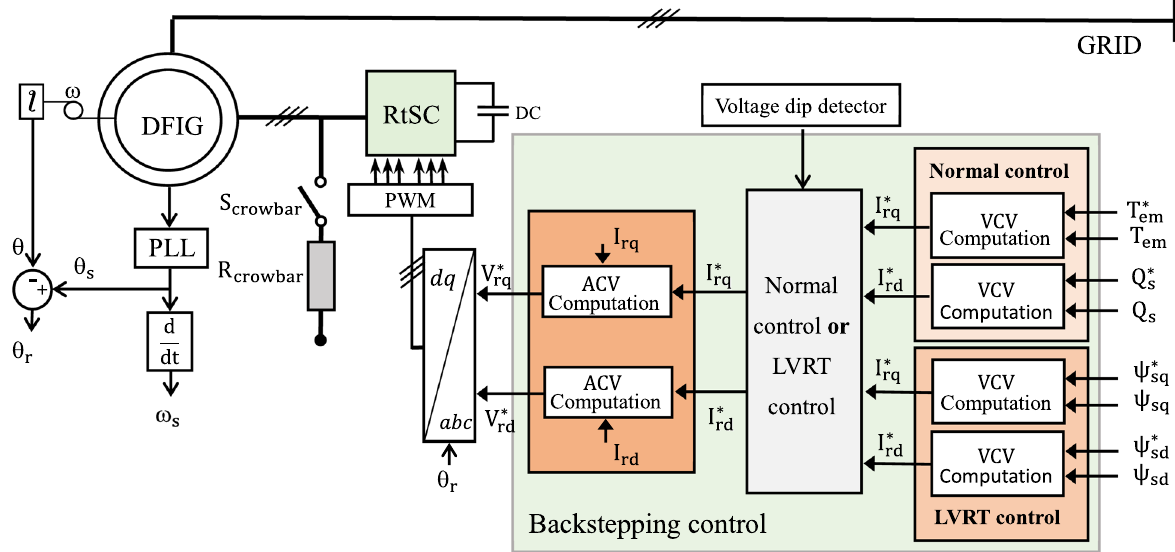
Fig. 7 Block diagram of the RtSC